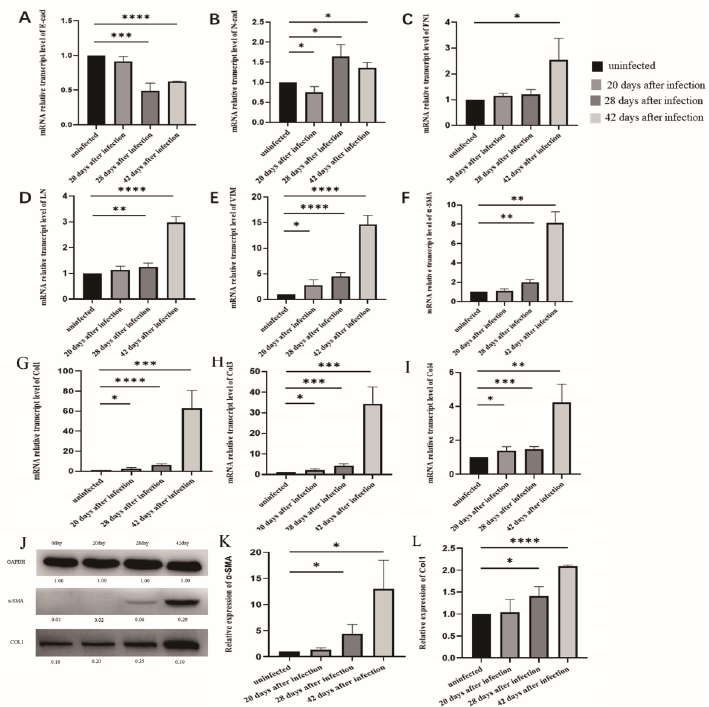
Figure 4. Fibrosis and EMT changes in the liver following infection with S. japonicum . ( A – E ) qPCR results of E-cadherin, N-cadherin, FN1, LN, and vimentin expression in the liver after infection. ( F – I ) qPCR results of α -SMA, collagen I, II, and III expression in the liver after infection. ( J – L ) Western blot results of α -SMA and collagen I expression in the liver after infection. * p < 0.05; ** p < 0.01; *** p < 0.001; **** p < 0.0001